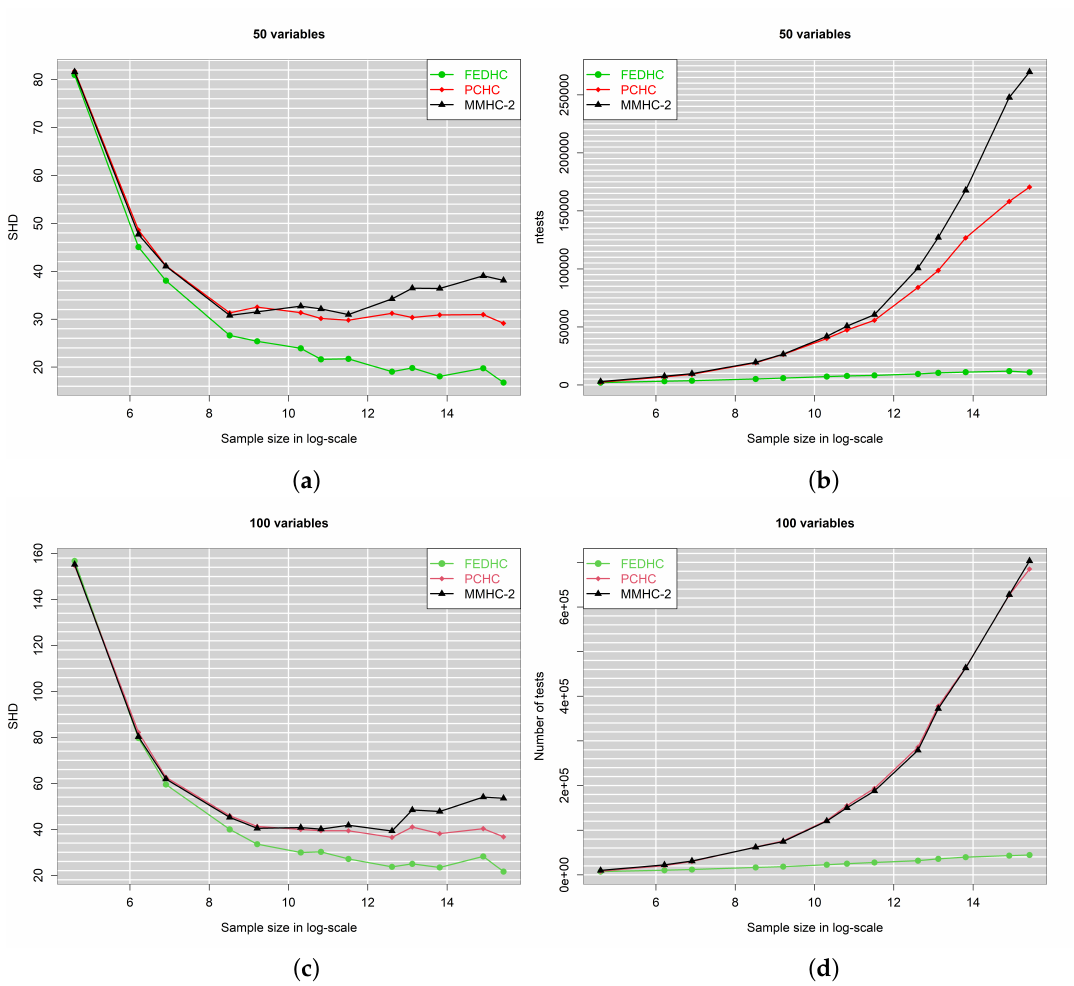
Figure 5. SHD and number of CI tests against log of sample size for various dimensions, with 5neighbours on average. ( a ) SHD vs. log of sample size. ( b ) Number of CI tests vs. log of sample size. ( c ) SHD vs. log of sample size. ( d ) Number of CI tests vs. log of sample